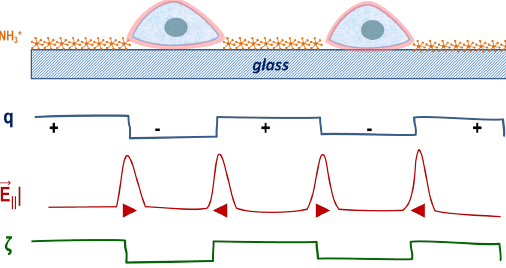
Figure 6. Depicted is the cross section of an NH 2 -terminated dendrimer printed glass sample where MG-63 osteoblastic cells are adhered. The difference in ζ potential between the molecules and glass (illustrated in green) lead to an alternating lateral electric field (red) at the glass–molecule interface.